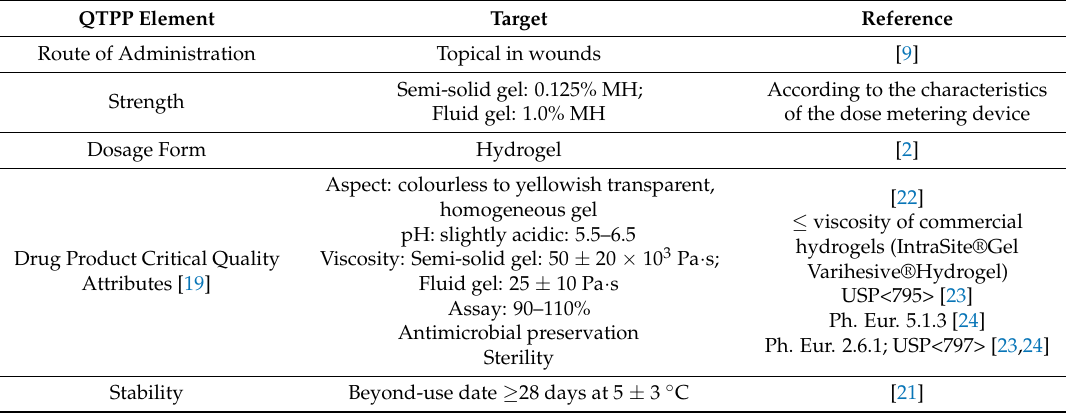
Table 1. Identification of quality target product profile (QTPP) of morphine hydrochloride (MH)